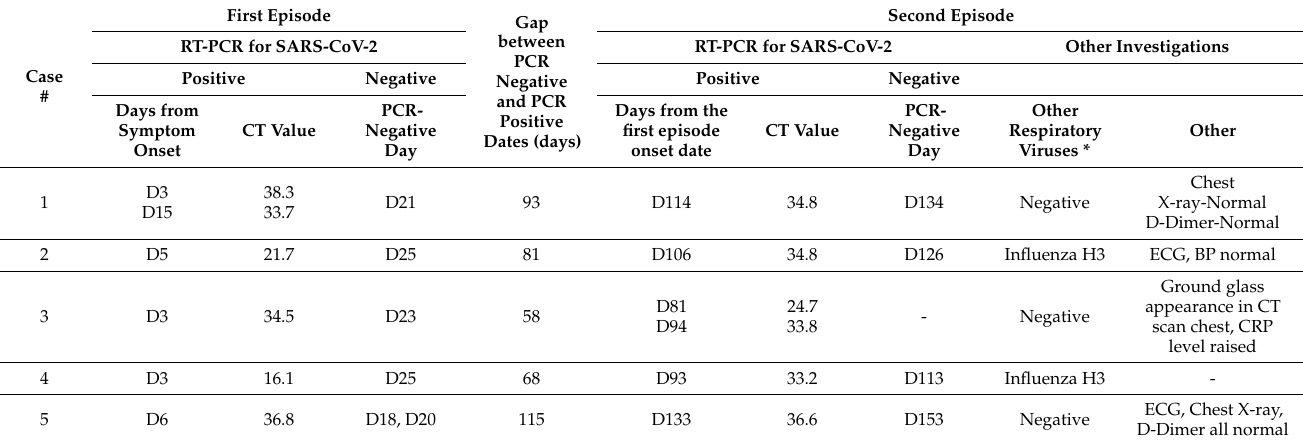
Table 2. Laboratory findings of the COVID-19 cases for both first and second episodes of